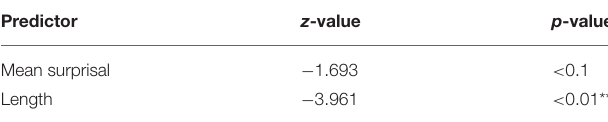
TABLE 6 | Most influential effects in the final GLM predicting Position, 1700–1750.